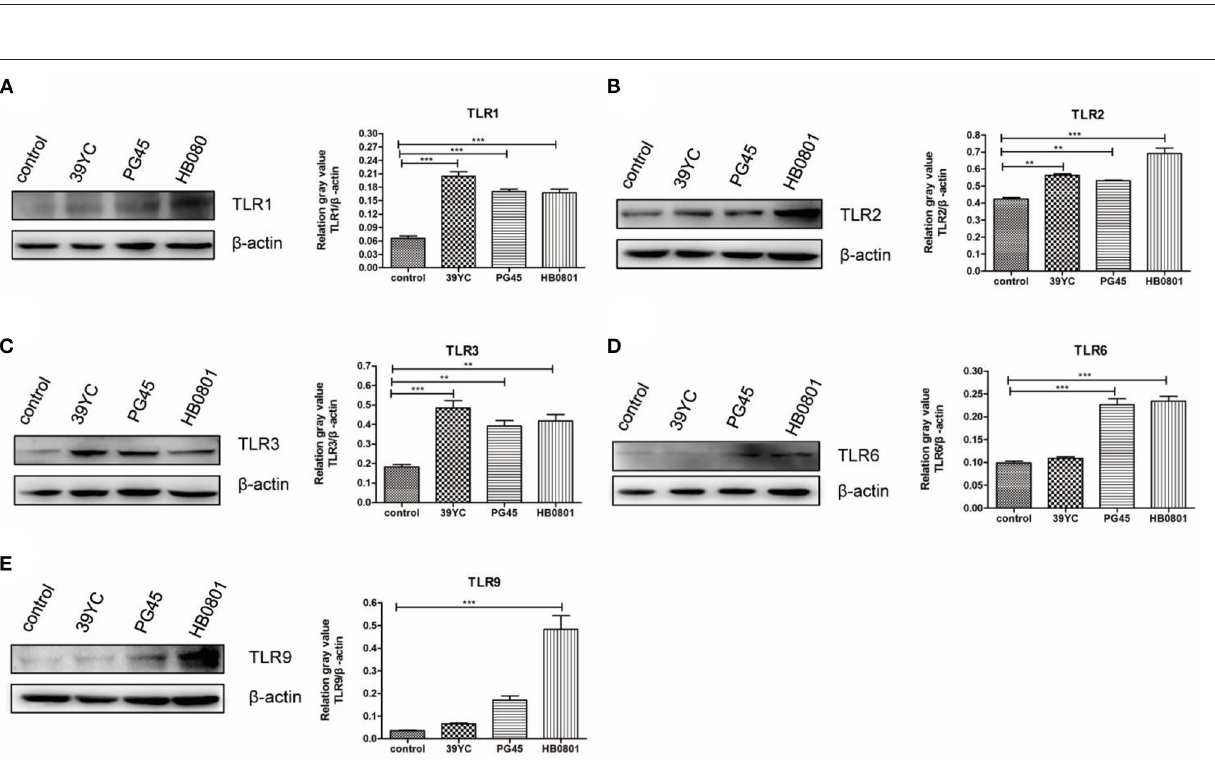
Frontiers in Veterinary Science |